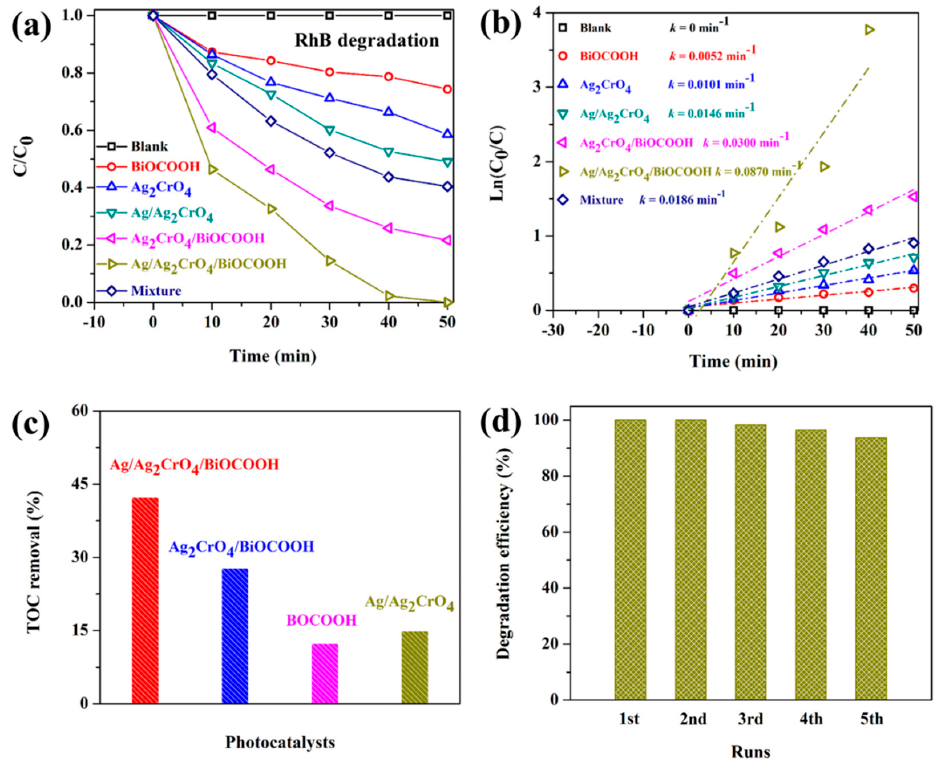
Figure 6. ( a , b ) Photocatalytic elimination of RhB (10 mg/L, 100 mL) aqueous solution over various samples (40 mg) under simulated solar light; ( c ) TOC removal of RhB (10 mg/L, 100 mL) aqueous solution over BiOCOOH, Ag/Ag 2 CrO 4 , Ag 2 CrO 4 /BiOCOOH and Ag/Ag 2 CrO 4 /BiOCOOH within 50 min of reaction. ( d ) Cycling test of Ag/Ag 2 CrO 4 /BiOCOOH for RhB degradation.